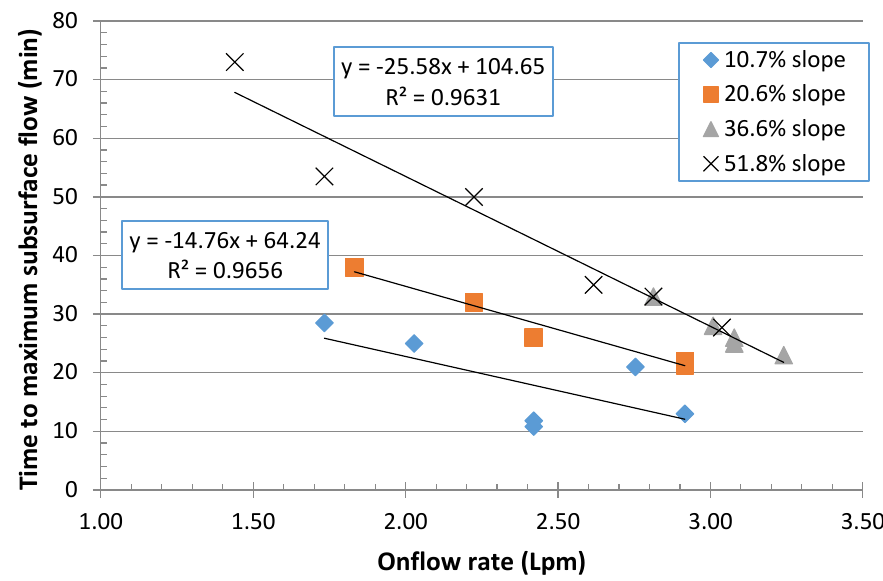
Figure 9. Time to maximum subsurface outflow rate as it depends on onflow rate for 143 mm depth sand at four different slopes.